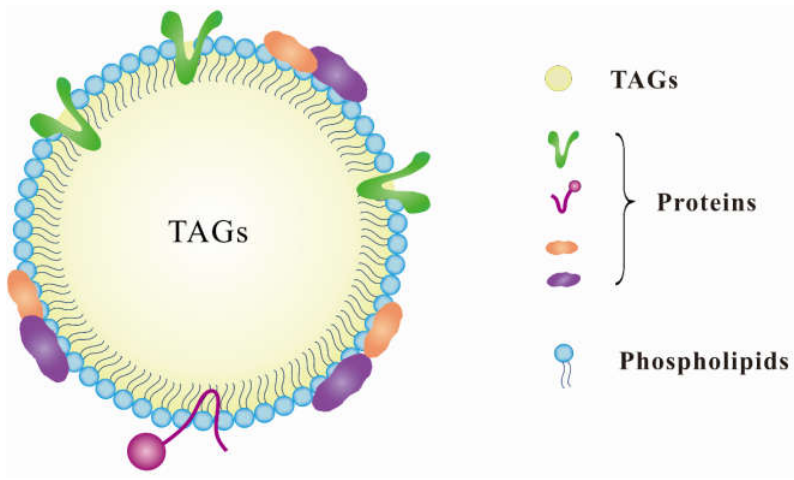
Figure 1. Schematic model of an LD’s structure. Abbreviations: TAGs, triacylglycerols. Table 1. The composition of lipid droplets extracted from various species.